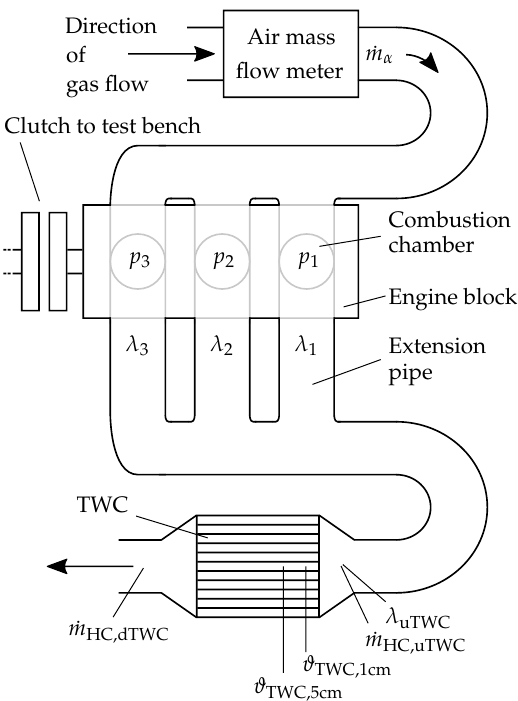
Figure 7. Schematic illustration of the relevant engine and sensor